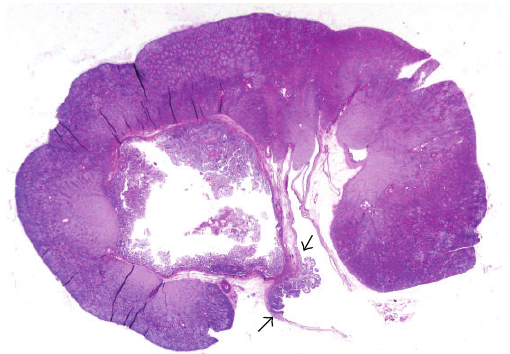
Figure 11: LS on a transitional cell carcinoma of the urinary pelvis demonstrates that the tumour shows two separate foci (arrows).